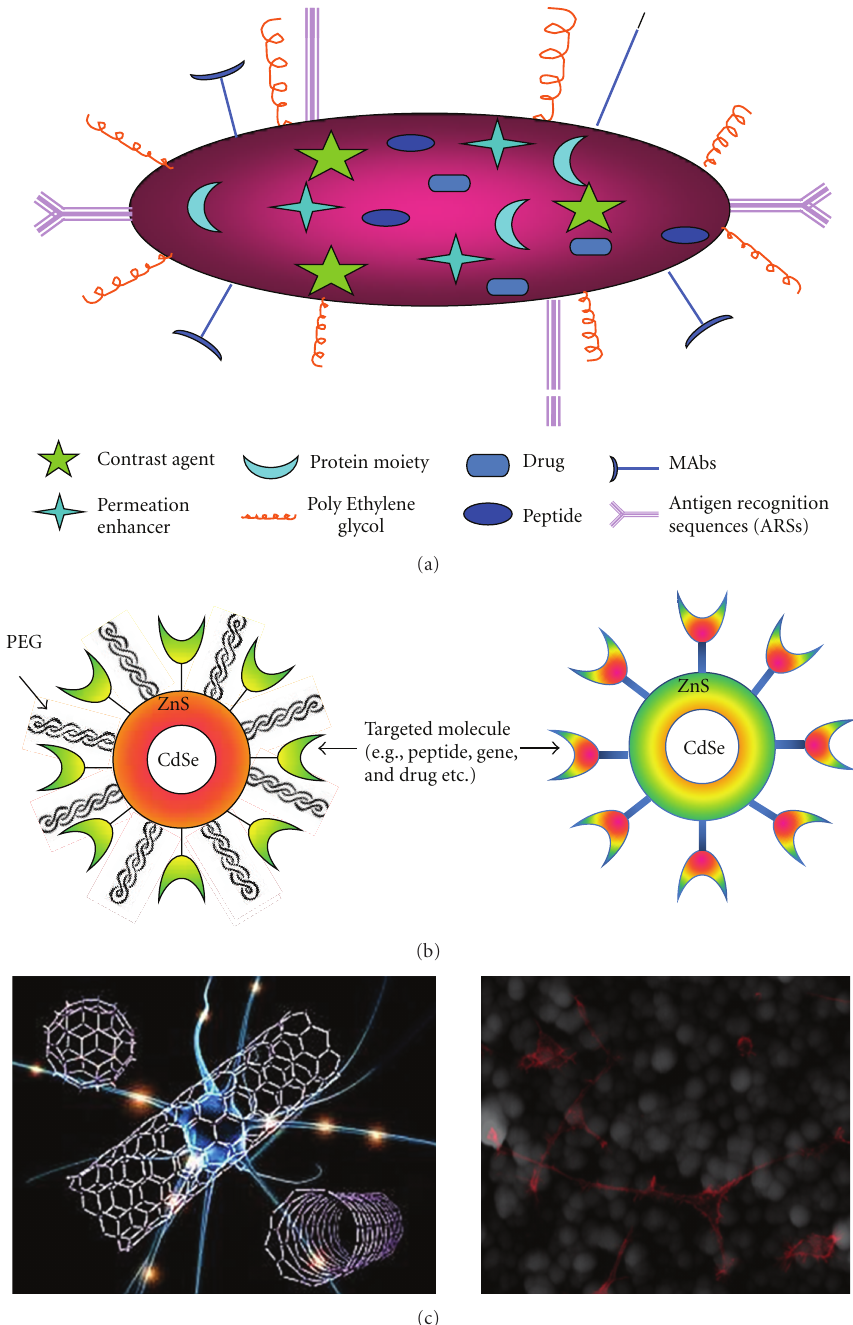
Figure 5: Multivariate nanocarriers. (a) multipartite nanostructure with targeting agent, permeation enhancer for BBB and RES, and multicomponent theranostic agent. PEGylation strategy for QDs for increasing uptake and combating BBB (b). (c) demonstrates interaction of neurons with the CNTs and fluorescently labelled neurons interaction with nanostructured